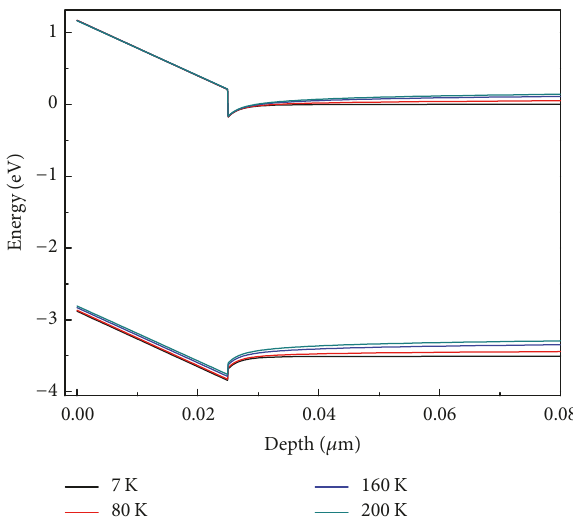
Figure 2: The energy band diagrams of AlGaN/GaN heterostruc- ture at different temperature.